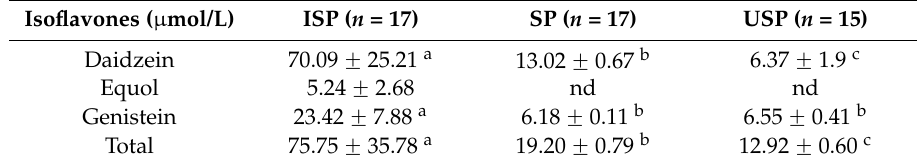
Table 4. Urine isoflavone profile of volunteers from different groups at the end of study (42 days). Isoflavones ( µ